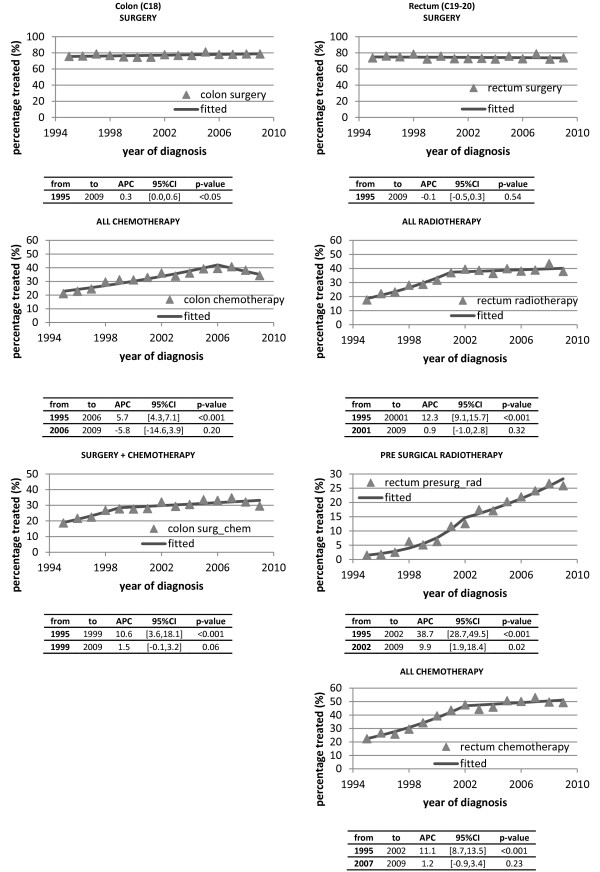
Percentage of patients treated with various modalities 1995-2009.